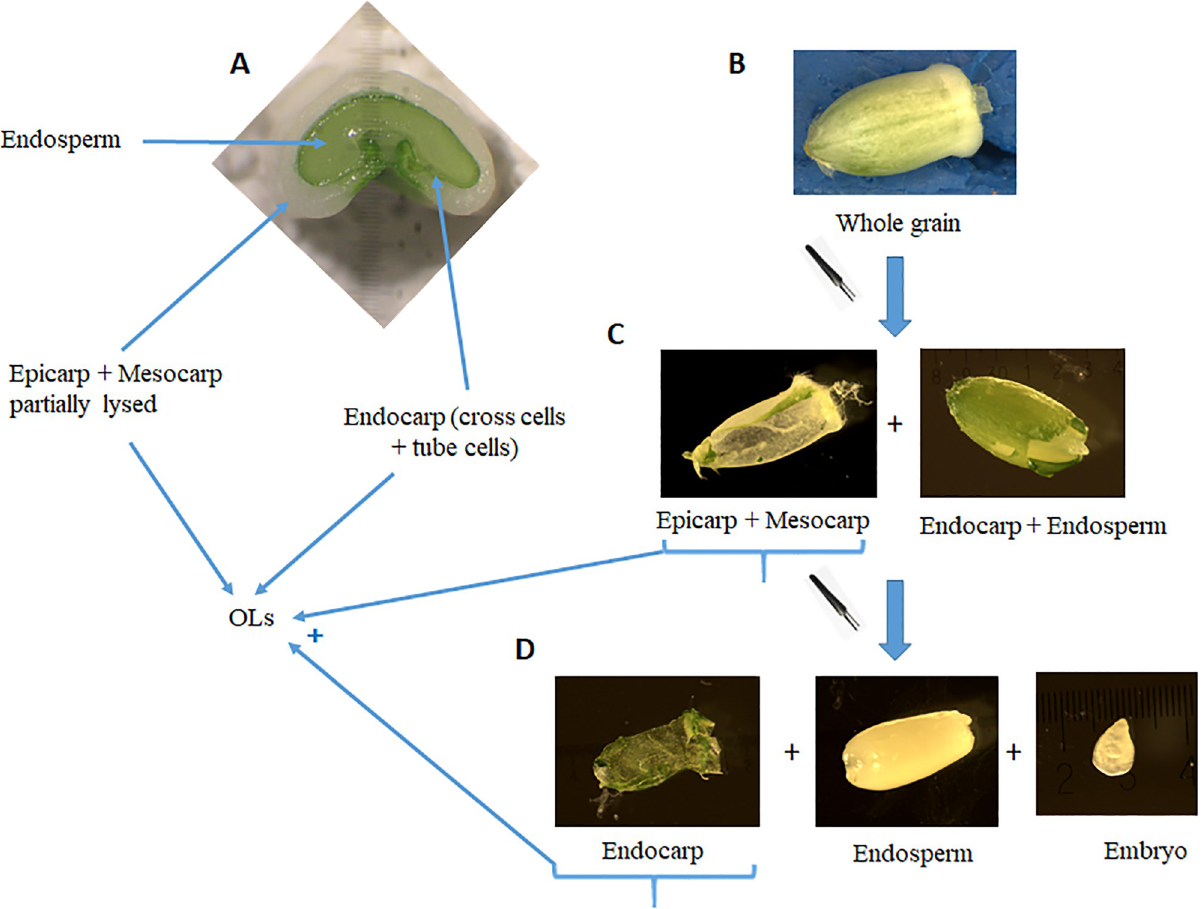
Fig 1. Pictures illustrating the dissected compartments. A representative fresh cross section of the grain (150˚DAA) showing the main different tissues (A): endosperm is composed of testa + aleurone layer + endosperm s.s. The three main steps of the grain dissection allowing the collection of the three main compartments of interest